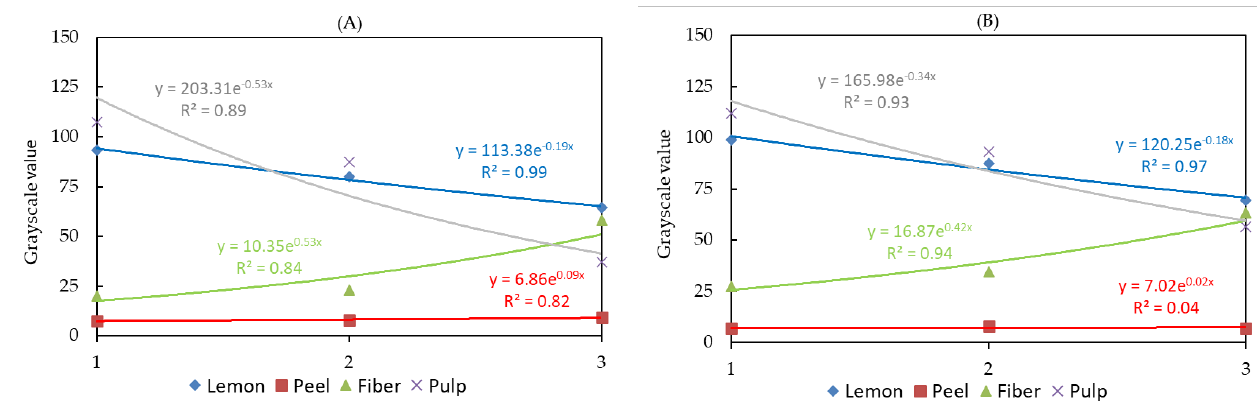
Figure 6. The linear regression results of (1) fresh, (2) mature, and (3) overripe lemons based on the four-layer stratification of lemon, peel, fiber, and pulp with ( A ) median-plane imaging and ( B ) axial-plane imaging.